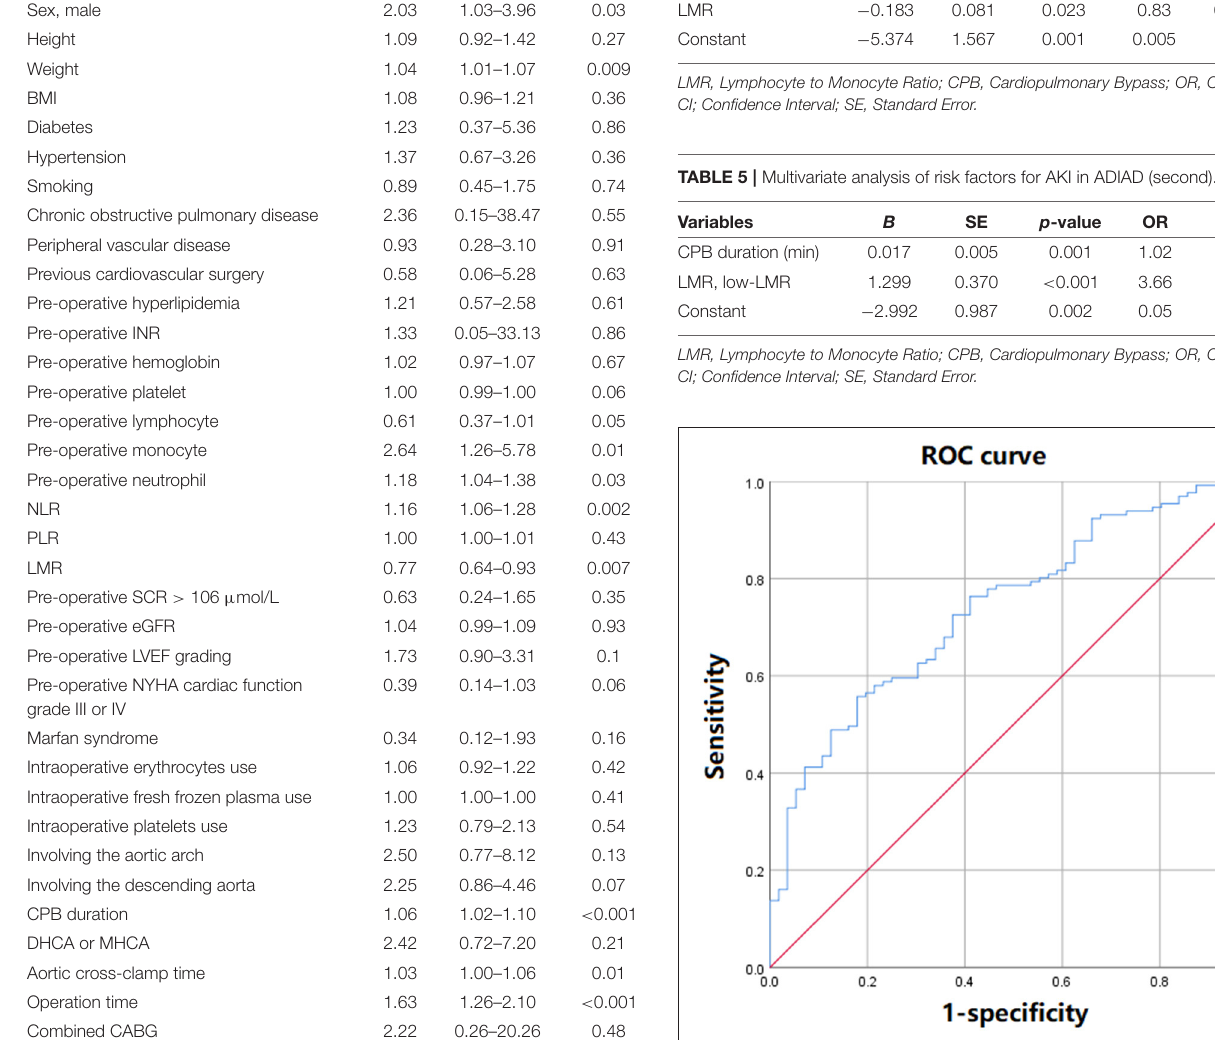
FIGURE 3 | The ROC curve of the predictive model of post-operative AKI incorporating LMR in ADTIAD. This figure shows the ROC curve of predictive models of post-operative AKI incorporating LMR in ADTIAD. AKI, Acute Kidney Injury; LMR, Lymphocyte-to-Monocyte Ratio; ROC, Receiver Operating